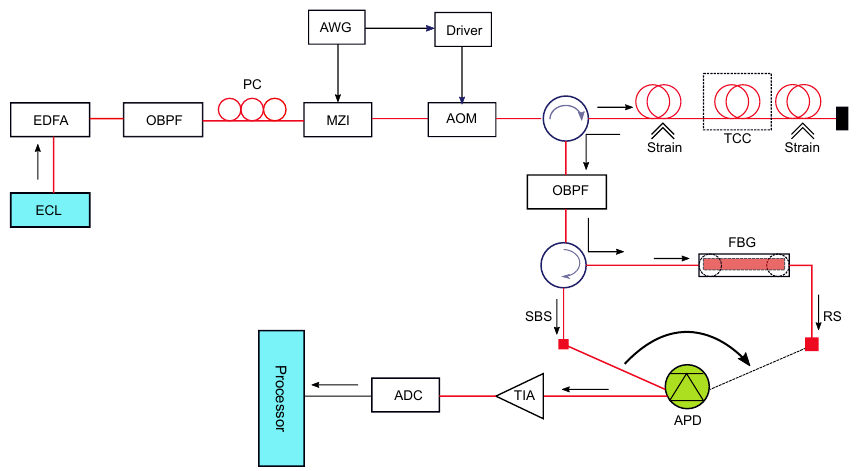
Figure 9. Experimental setup of the Stimulated Brillouin scattering (SBS) implementation of the BDTS system. OF: Optical Filter, PC: Polarization Controller, MZI: Mach–Zehnder Interferometer, BPF: Band-Pass Filter, SBS: Stimulated Brillouin Scattering, WFG: Waveform Generator, ADC: Analog-to-Digital Converter, RS: Rayleigh Scattering, FBG: Fiber–Bragg Grating, ECL: External Cavity Laser, EDFA: Erbium Doped Fiber Amplifier, APD: Avalanche Photo Detector, and TIA: Transimpedance Amplifier. (Adapted from